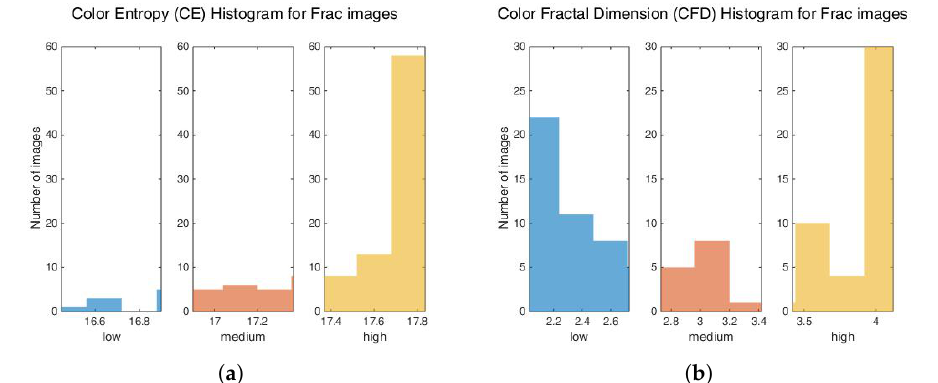
Figure 4. Color Entropy Histogram ( a ) and Color Fractal Dimension ( b ) for Frac images regarding complexity levels. Adapted from Ref. [48].